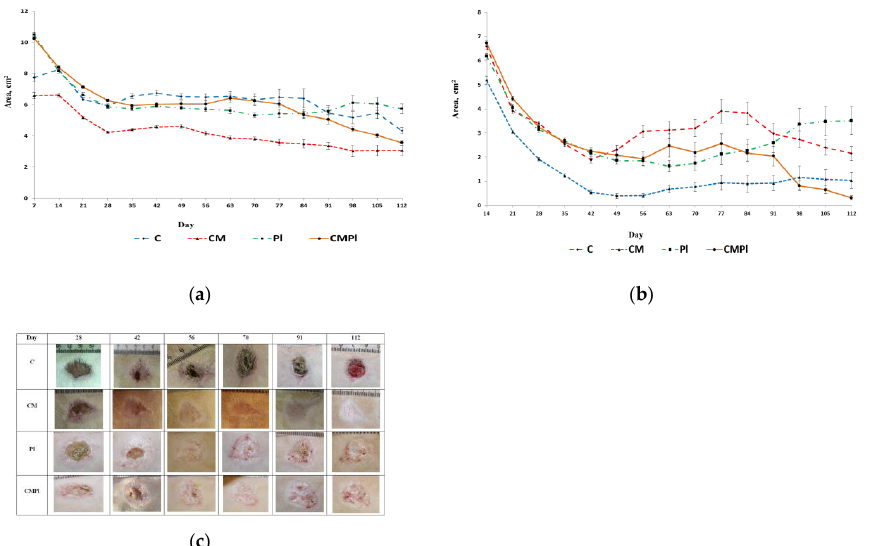
Figure 2. Dynamics of the LRI of animals: ( a ) dynamics of development of visible region of rat skin changes that occurred under X-ray radiation; ( b ) dynamics of development of an open wound surface of rat skin after exposure to X-ray radiation; ( c ) dynamics of healing of an open wound surface of the skin in animals (C: irradiated rats without subsequent therapy, CM: irradiated rats that received intradermal administration of culture medium (MesenCult) concentrate, PL: therapy of LRI using MSC derived from the placenta, CMPL: therapy of LRI using a concentrate of conditioned medium collected from a culture of the MSCs). Table 1. The area of the total changed surface of animal skin in LRI (cm 2 ).